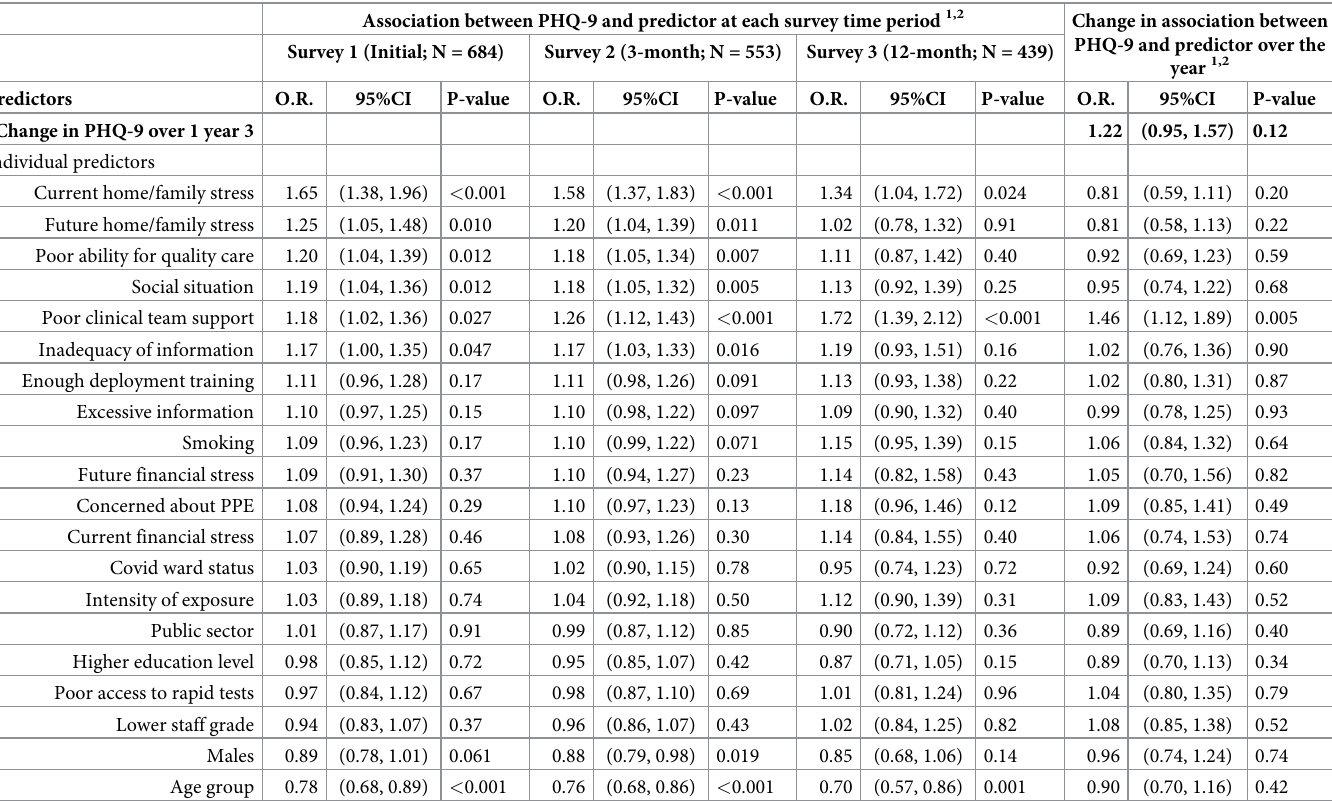
Table 6. Relative impact of predictors on Patient Health Questionnaire (PHQ-9) score in responses over the year of surveys. Association between PHQ-9 and predictor at each survey time period 1,2 Change in association between PHQ-9 and predictor over